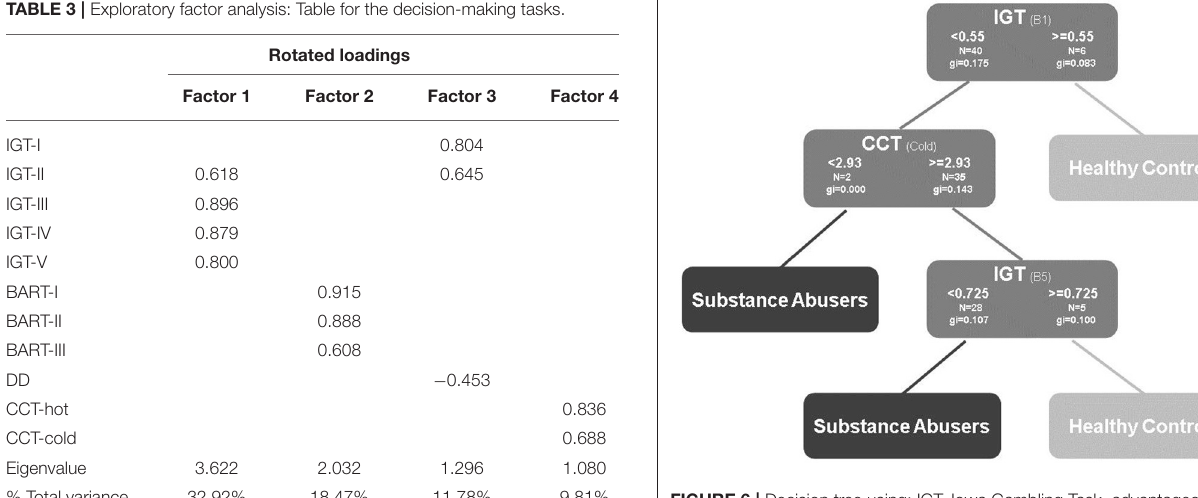
FIGURE 6 | Decision tree using: IGT, Iowa Gambling Task, advantageous selections by 20-trials blocks; BART, Balloon Analog Risk Task, average number of adjusted balloons; CCT-cold and CCT-hot, Columbia Card Task, average number of card selections; DD, AUC of delay